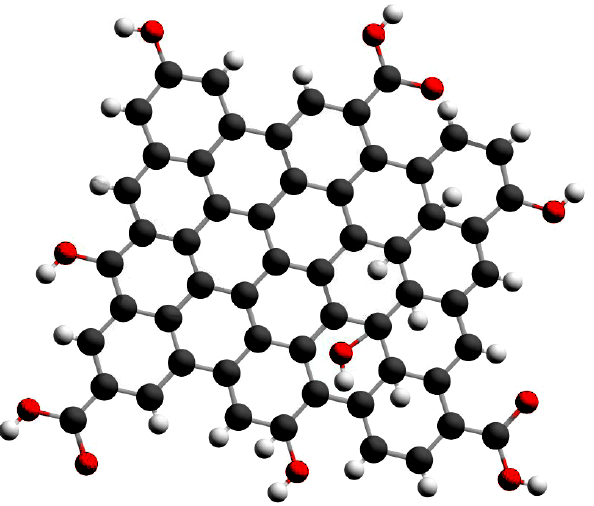
Figure 1. Graphene quantum dot. ( : Carbon, : Hydrogen, : Oxygen).